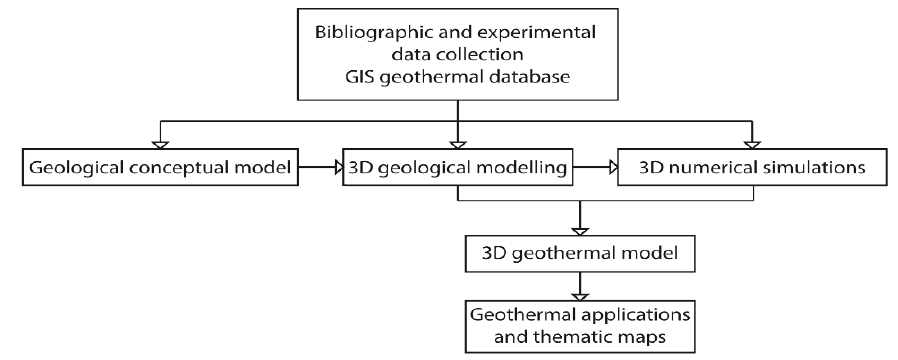
Figure 1. Proposed methodology.